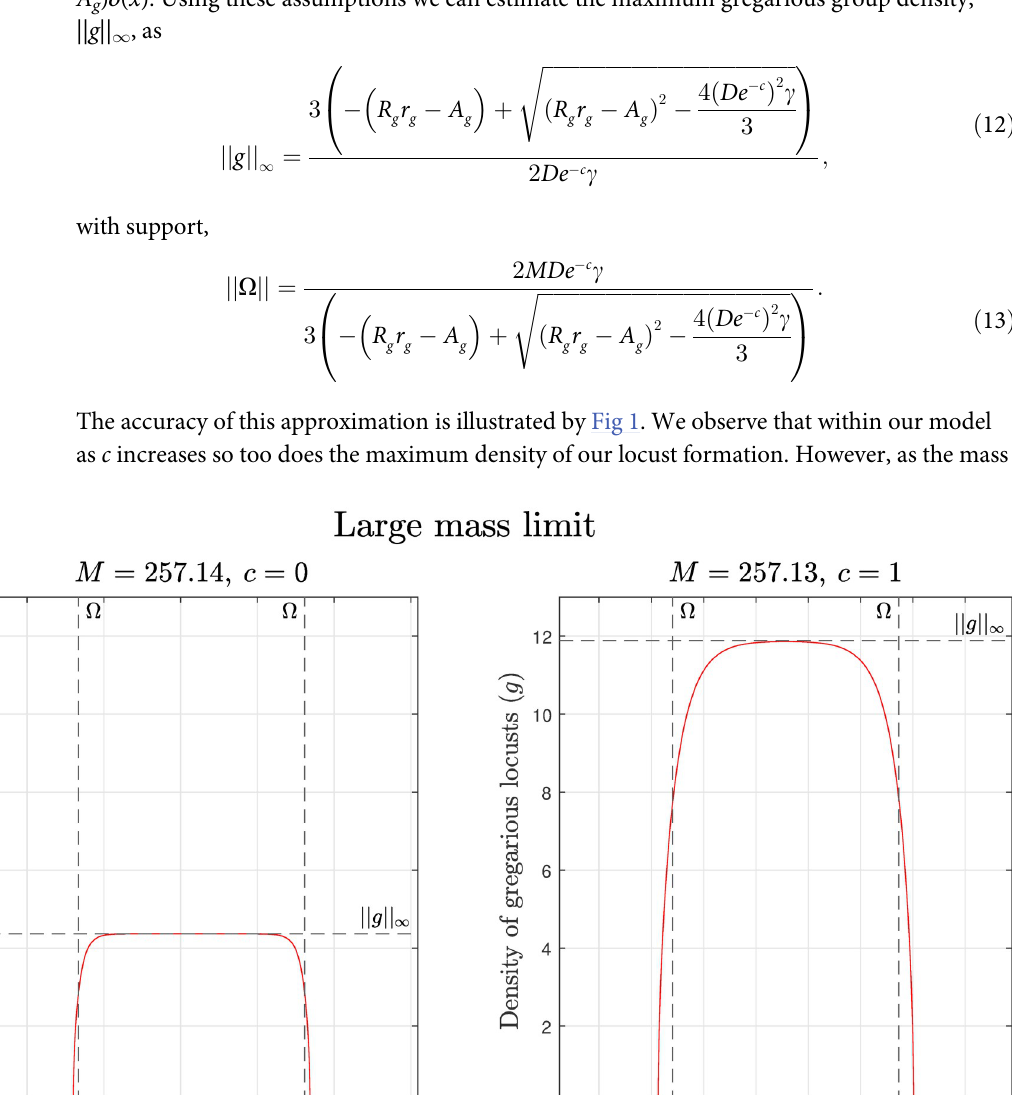
= 0.25, r = 0.5, A = g g g